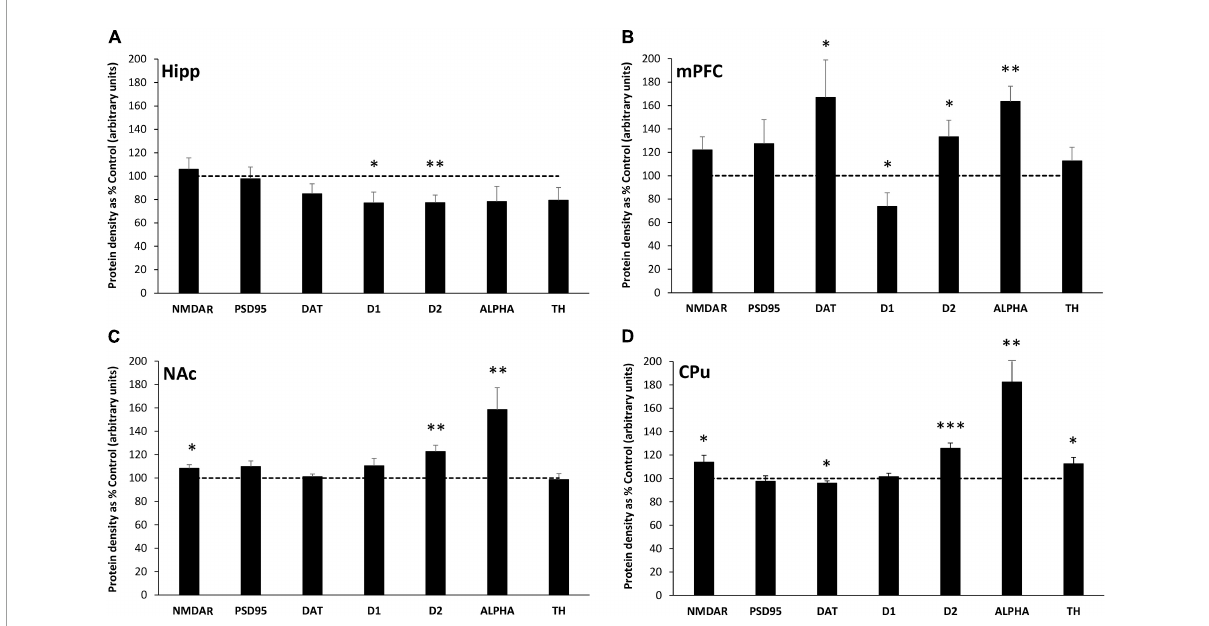
FIGURE1 MatSep modifies synaptic protein expression in the Hipp (A) , mPFC (B) , NAc (C) and CPu (D) . Densitometric analysis of synaptic protein expression, normalized to actin and averaged over at least 3 separate blots, is presented from MatSep animals ( n = 7–8/group) expressed as% control (mean ± SEM). The dashed line indicates the 100% control level of expression. Statistically significant differences between MatSep and Control are designated by: ∗ p ≤ 0.05; ∗∗ p ≤ 0.01, ∗∗∗ p ≤ 0.001. NMDAR, N-methyl-D-aspartate (NMDA) receptor; PSD95, postsynaptic density 95 protein; DAT, dopamine transporter; D1, dopamine receptor-1; D2, dopamine receptor-2; ALPHA, α -synuclein; and TH, tyrosine